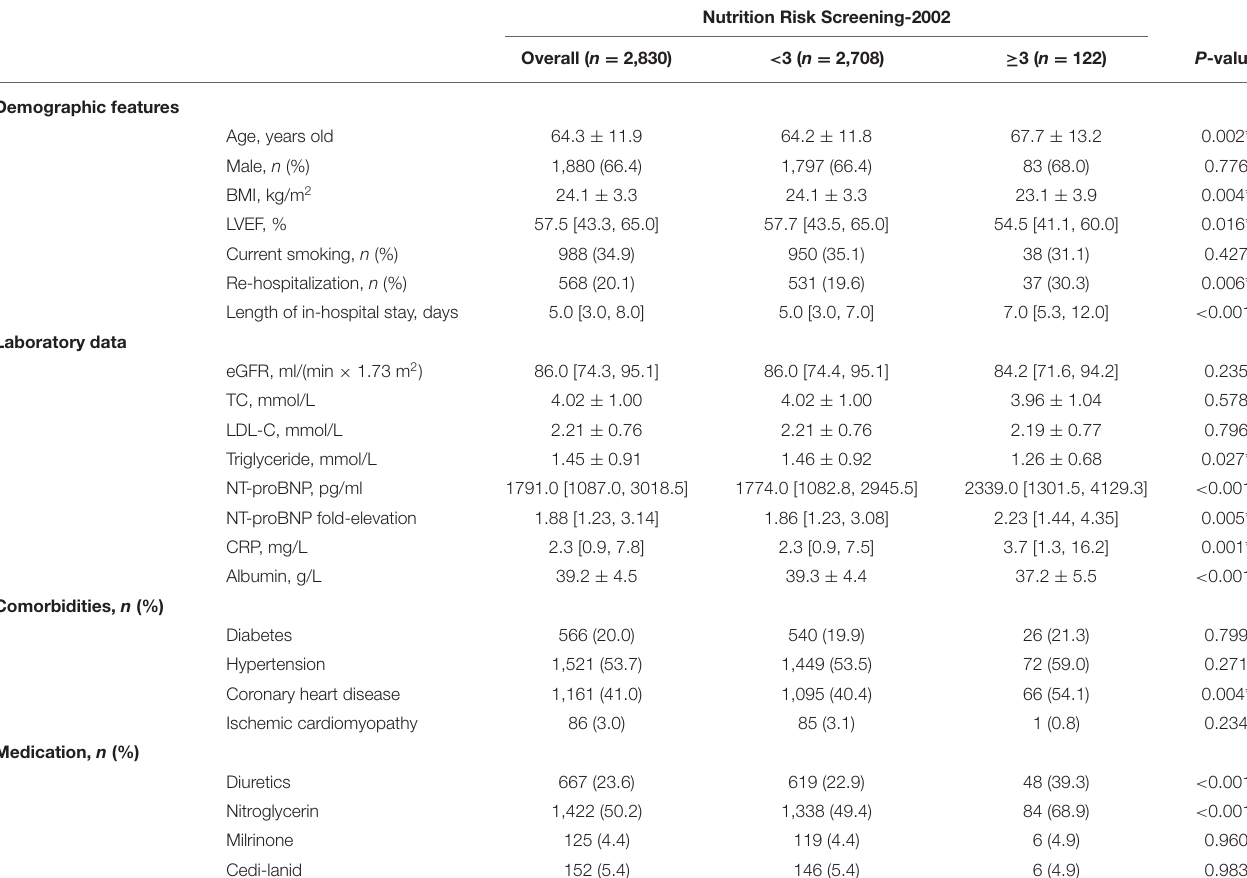
TABLE 1 | Baseline characteristics of patients stratified by nutritional